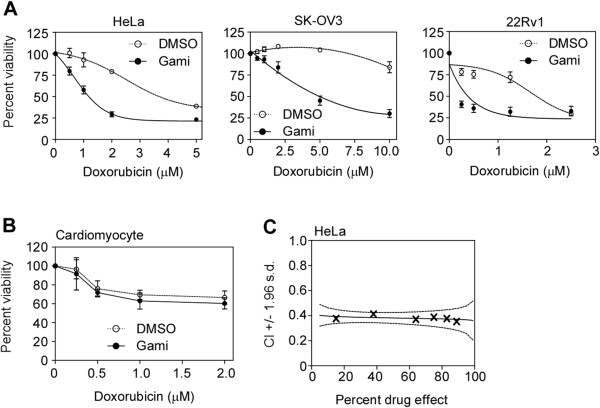
Combination treatment with DOX and gamitrinib. (A) Gamitrinib sensitizes cancer cells to DOX treatment. HeLa, SK-OV3, and 22Rv1 cells were treated with various concentrations of DOX in the absence (open circles) or presence of 5 μM, 10 μM, and 2.5 μM gamitrinib (closed circles), respectively, for 24 hours. Cell viability was analyzed by MTT assay. Percent viability was expressed as a percentage relative to 0 μM DOX-treatment. (B) Effect of combination treatment on cardiomyocytes. Mouse primary cardiomyocytes were treated in the absence (open circles) or presence (closed circles) of 5 μM gamitrinib for 24 hours and analyzed by MTT assay. (C) Graphical representation of combination index (CI) for HeLa cells. The MTT data were analyzed using CalcuSyn software to generate CI values. The 95% confidence interval of CI (mean ± 1.96 × standard deviation) is depicted as dotted lines.